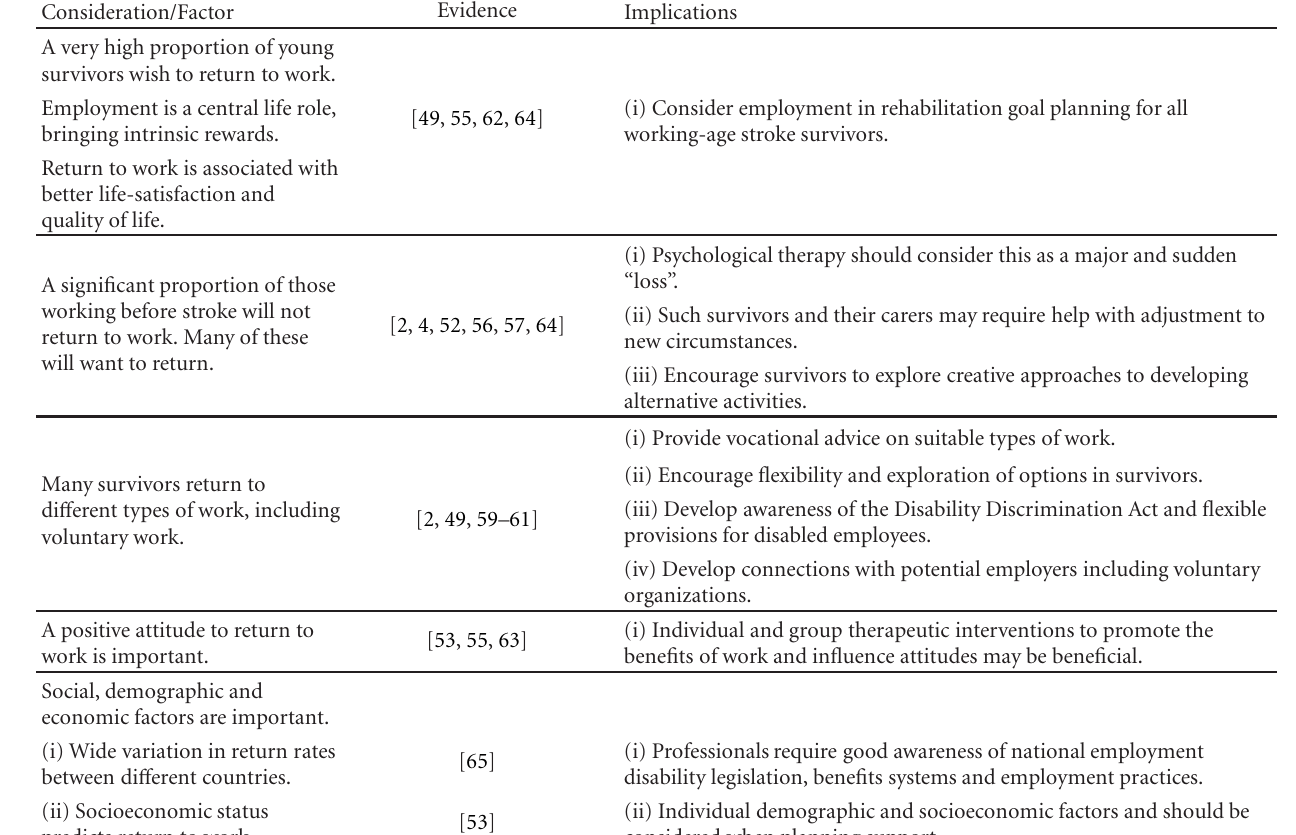
Table 3: Promoting return to